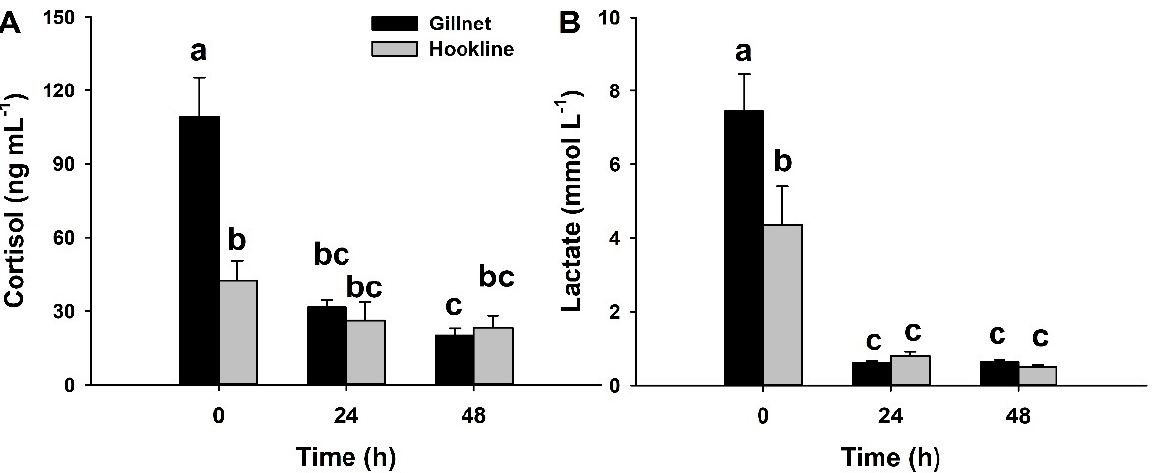
Figure 2. Serum cortisol ( A ) and lactate ( B ) in P. mediterraneus captured by gillnet (black bars) or hookline (grey bars). Fish were sampled immediately after capture (0 h) or at times 24 h and 48 h after their introduction into floating sea cages. Data are expressed as mean + SEM (n = 8–25 per column). Different lowercase letters indicate significantly different groups ( p < 0.05, two-way ANOVA followed by a post hoc Tukey test).